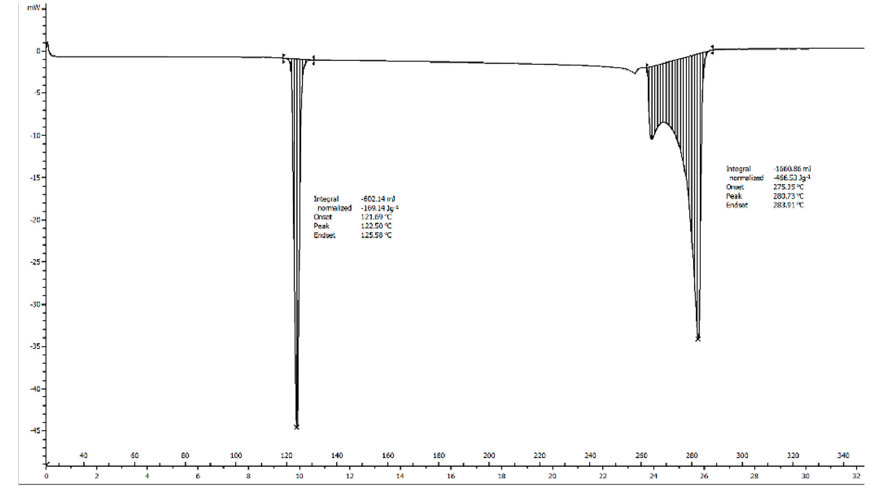
Figure A4. DSC thermogram of benzoic acid crystallized in neat ethanol.